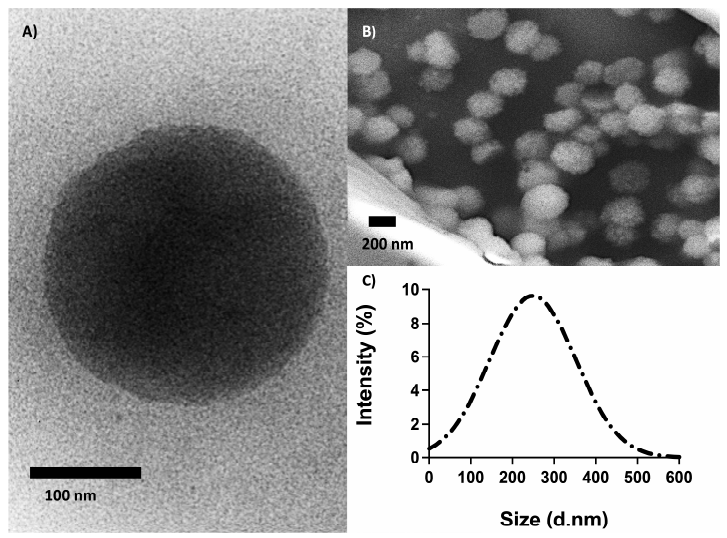
Figure 3. ( A ) Transmission electron- and ( B ) scanning electron micrographs, and ( C ) DLS size distribution of oxytocin imprinted nanoparticles.